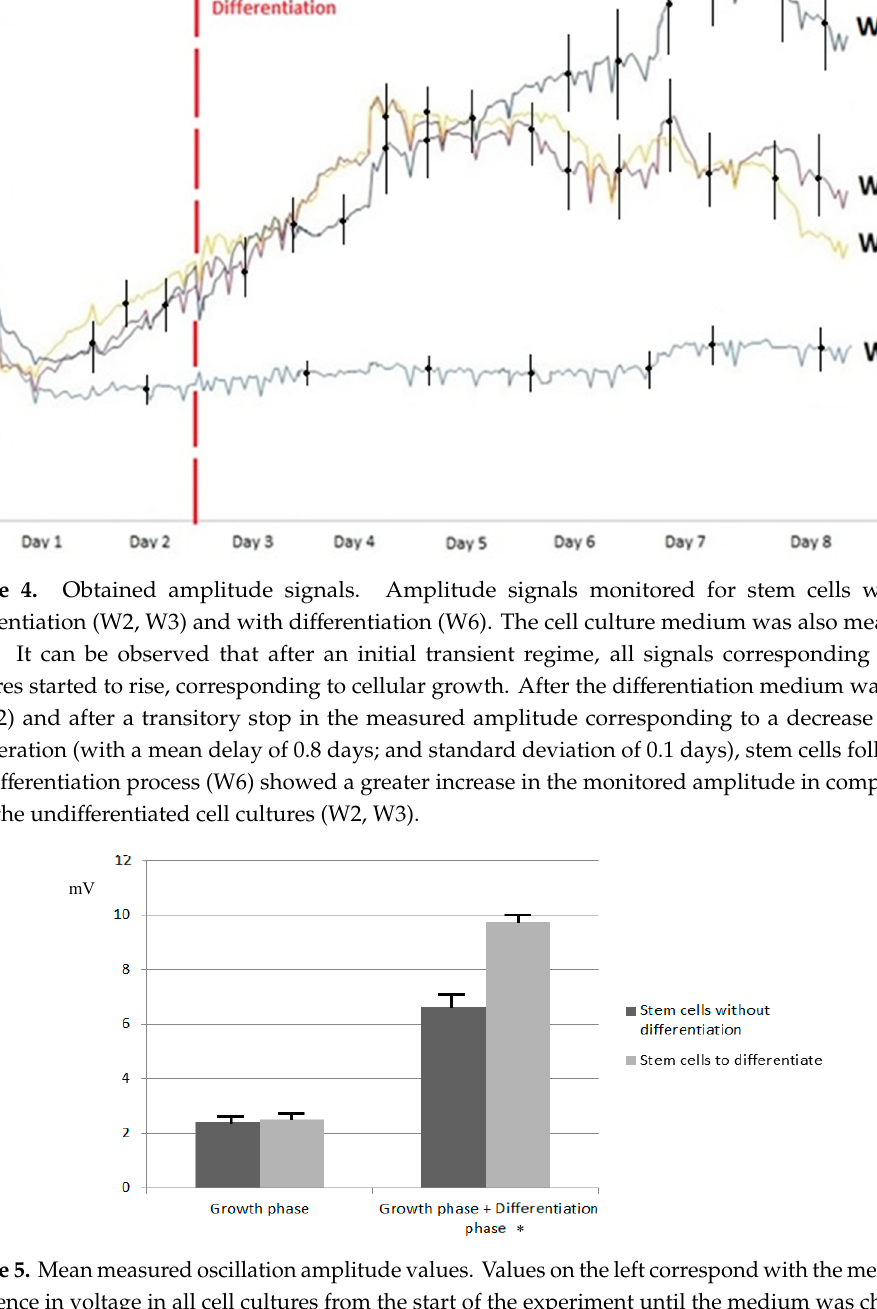
* Figure 5. Mean measured oscillation amplitude values. Values on the left correspond with the measured di ff erence in voltage in all cell cultures from the start of the experiment until the medium was changed to the di ff erentiation medium. Values on the right correspond with the di ff erence of voltage measured between the start of the experiment and the maximum amplitude measured. We can see a greater rise in amplitude measured in the cell cultures where di ff erentiation took place. Bars indicate the standard deviation. * With a significance level set at 0.05, the p -value obtained was p = 0.031.